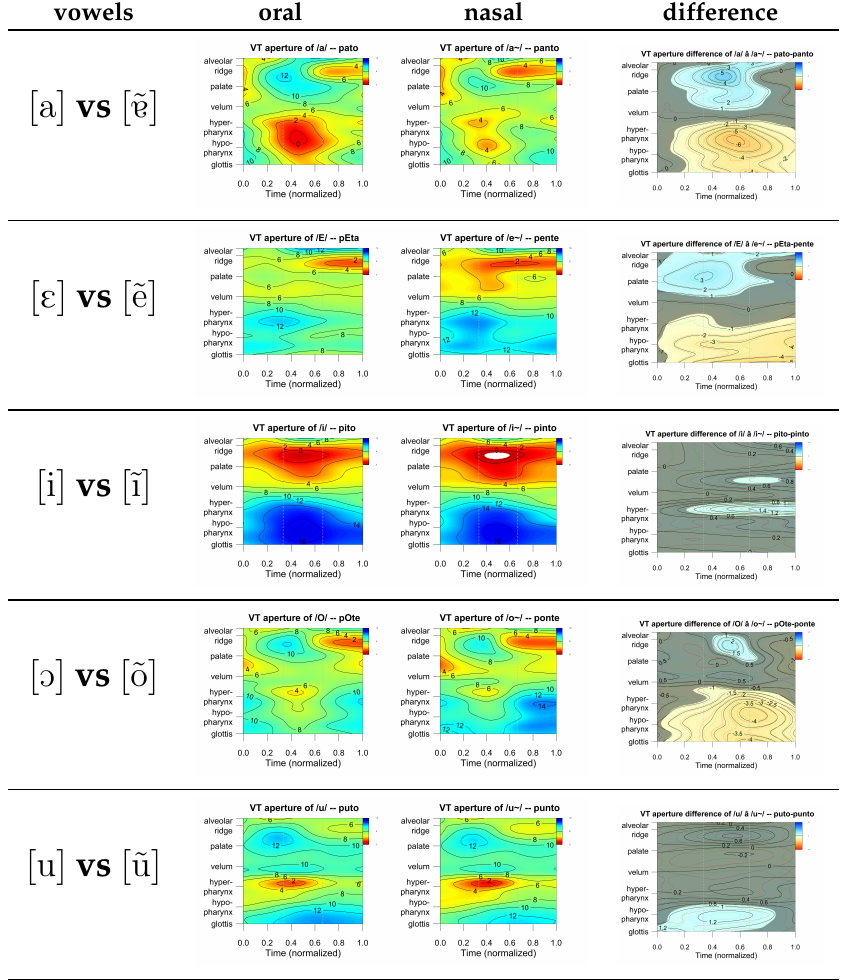
Figure 3. Results from GAMMs for the five vowel pairs in /p/ context. From left to right, in each row, the plots refer to the oral vowel, the nasal vowel, and the difference between the two. Each GAMM is plotted considering normalized time, from 0.0 to 1.0, and encompasses the previous consonant /p/, the vowel (at the center, from 0.33 to 0.66), and the next consonant. The results for the /m/ context presented similar patterns and are not shown. The plots from the first two columns consider a color scale from 0 (red) to 16 (blue), from a narrower to wider aperture. The rightmost column uses shades of blue for positive difference values and red for negative values, with the gray areas meaning that the GAMMs are very similar.